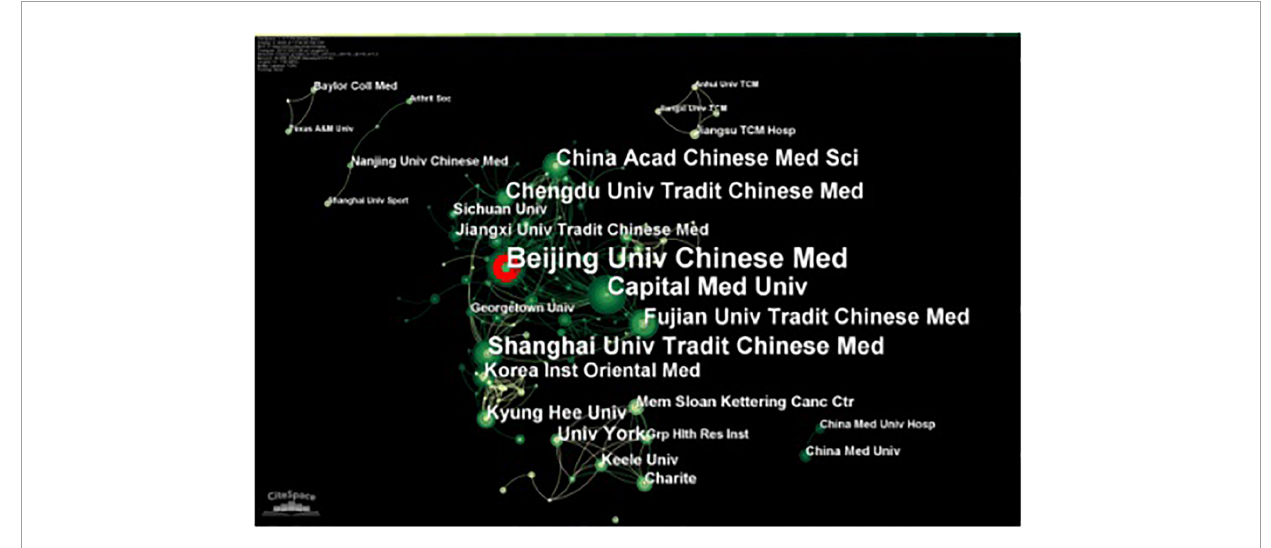
FIGURE3 The collaboration map of institutions related to traditional Chinese non-pharmacological therapies on knee osteoarthritis (KOA).